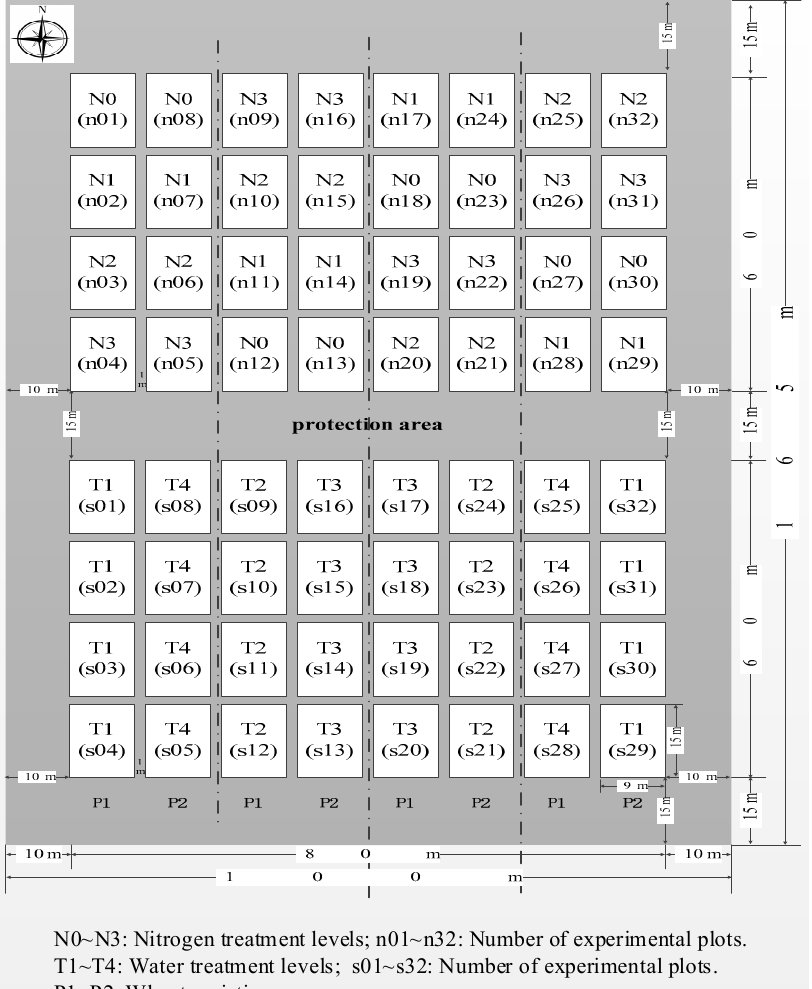
Figure l. The schematic plot of our experimental design. Figure 1. The schematic plot of our experimental